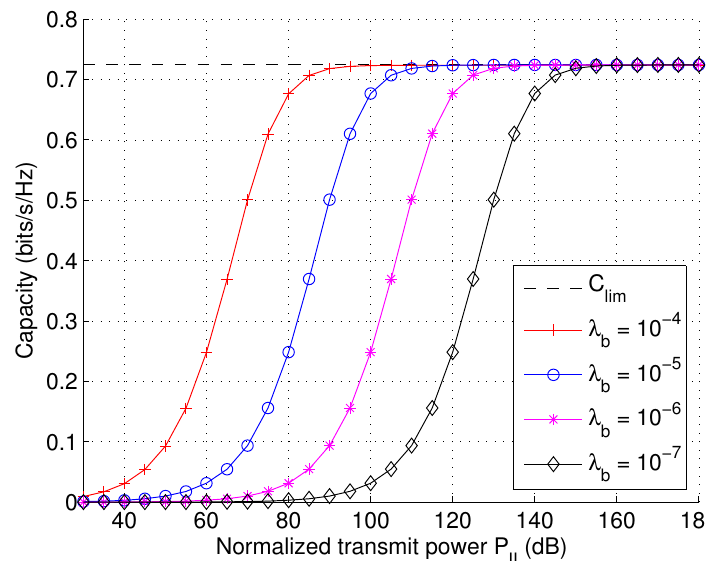
Figure 5. Maximum capacity per device as a function of transmit power P II with varying infrastructure density λ b ( λ b / λ u